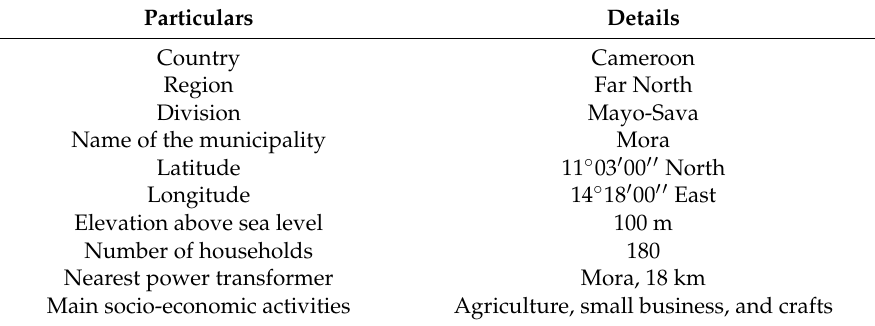
Figure 3. Geographical situation of the study location. Table 2. General information about the study location.